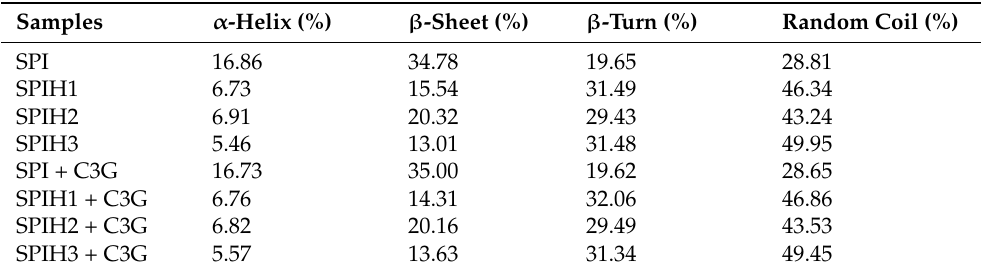
Table 3. CD analysis of the secondary structures of 100 µ g/mL SPI/SPIHs with or without 1 µ g/mL C3G at pH 7.0, determined using the CDNN program.